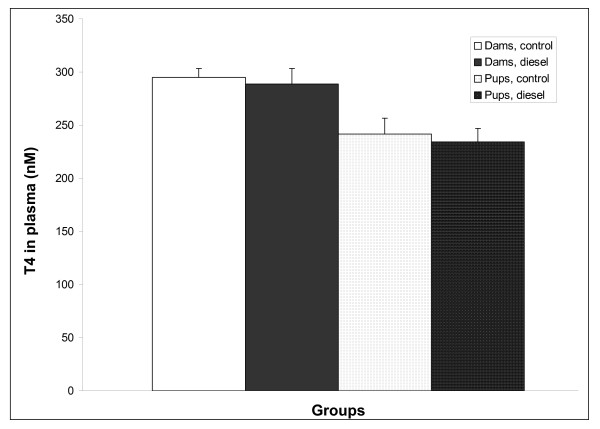
T4 plasma hormone levels in mothers and offspring. Blood for T4 plasma hormone levels were collected at the time of weaning and measured by immunoassay. Data represent mean+SEM, n = 11–12 for the dams. Data for male and female pups were similar and were therefore collapsed within each prenatal exposure group, n = 9.